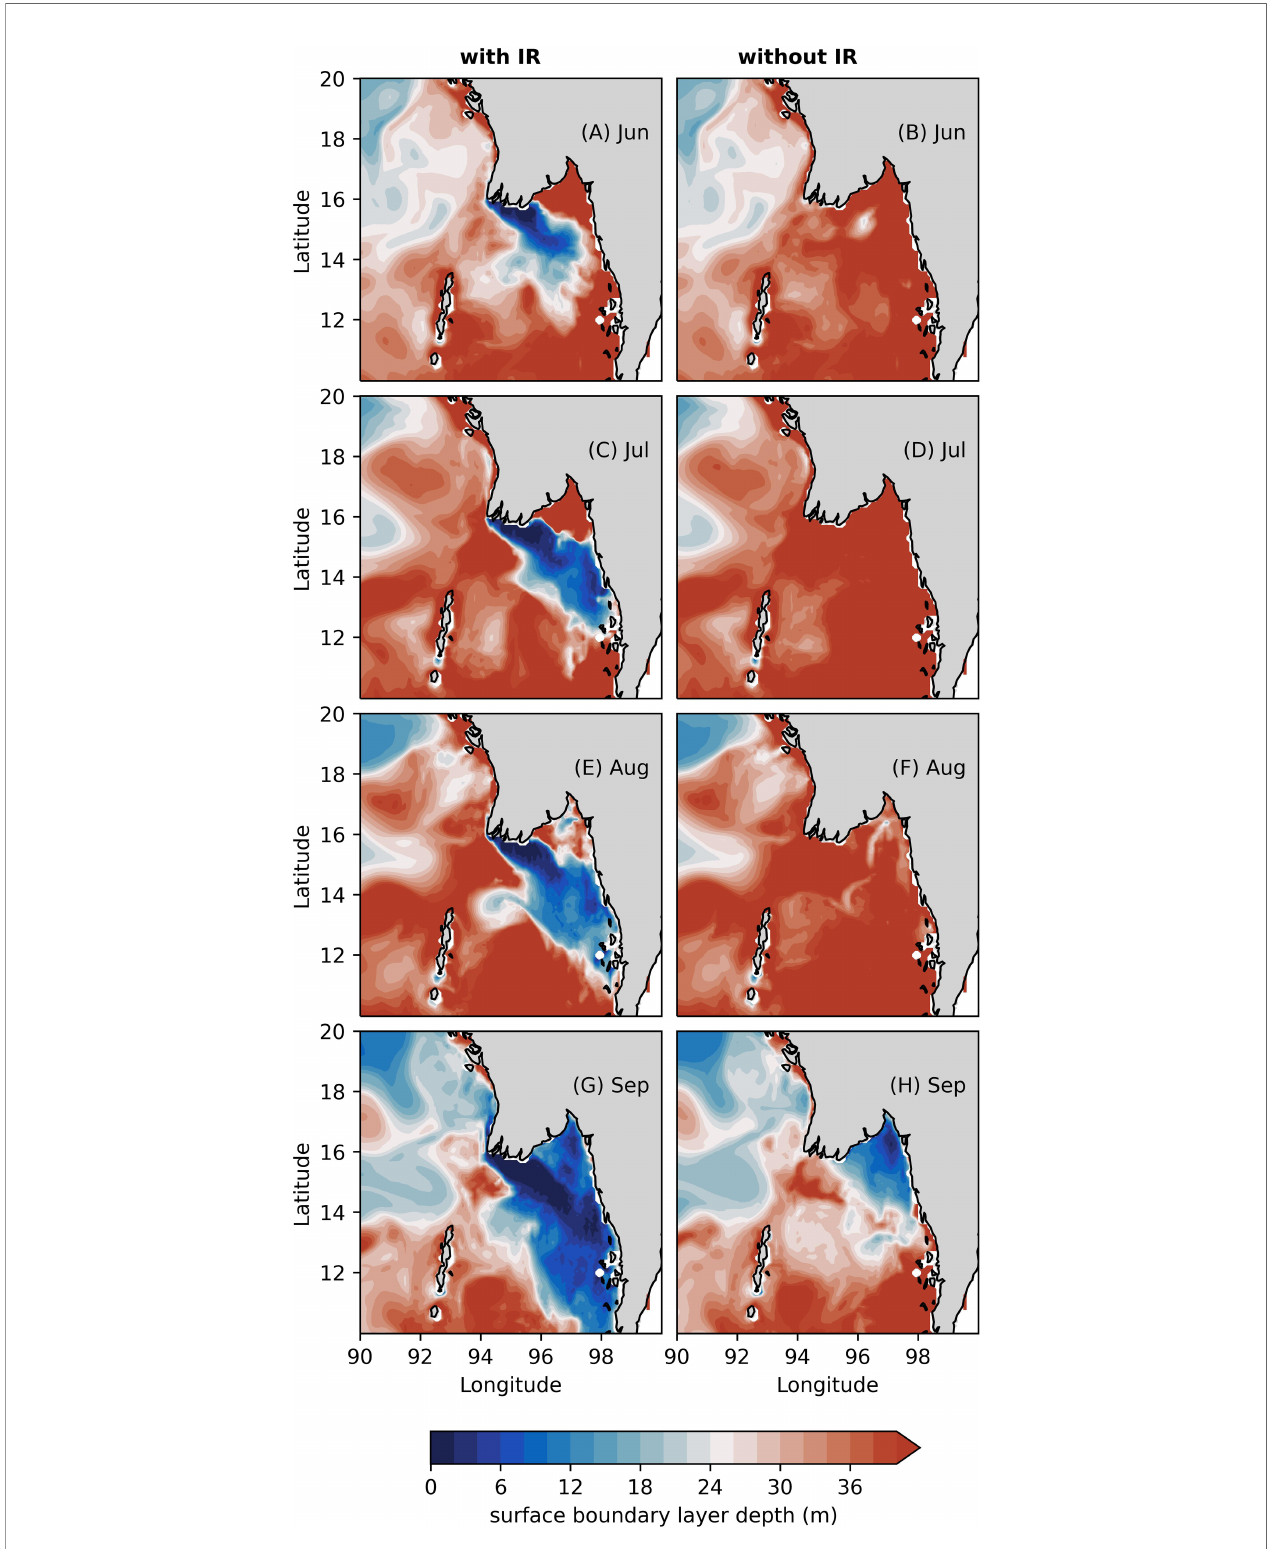
FIGURE 15 | Comparison of the spatial distribution of monthly mean surface boundary layer depth from the fi rst year of experiment IRFullW ( fi rst column) and SpinFullW (second column) for the months of summer monsoon.